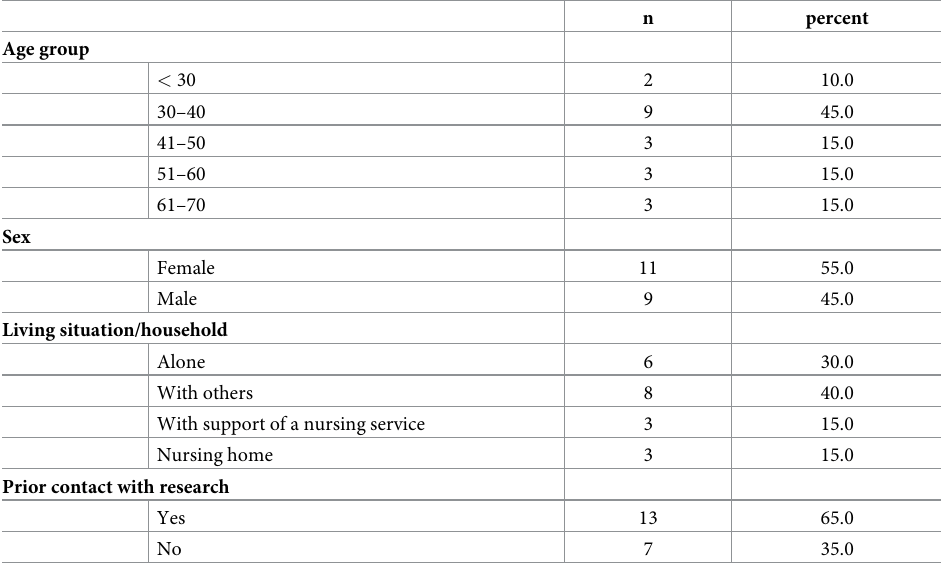
Table 2. Characteristics of legally supervised persons (n =